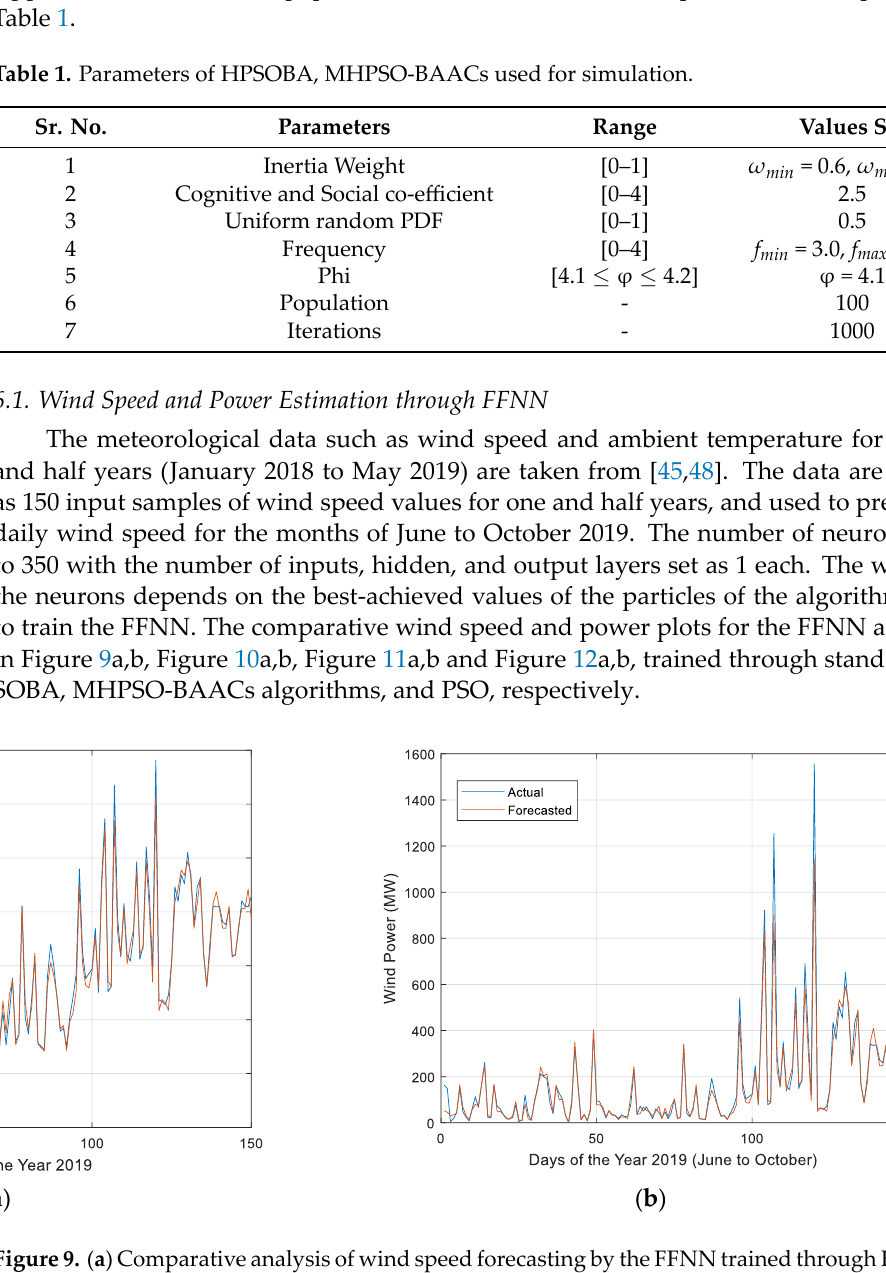
Table 1. Parameters of HPSOBA, MHPSO‑BAACs used for simulation. Sr. No.